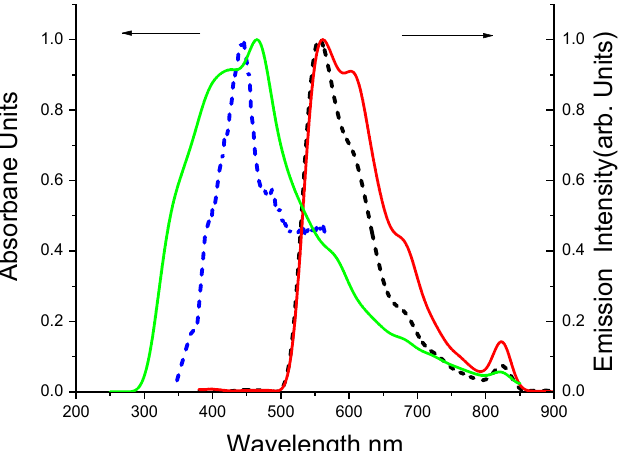
Figure 3. Normalized absorption and fluorescence spectra of 1.41 × 10 − 5 M DBDMA in DMF were described in solid media. The line represents the absorption and represents the fluores- cence spectra in photosol-gel matrix, while ـ ـ ـ represents absorption and ـ ـ ـ represents fluorescence spectra in sol-gel matrix ( λ ex = at λ ab max ). Table 1. Photophysical parameters of DBDMA in different media.